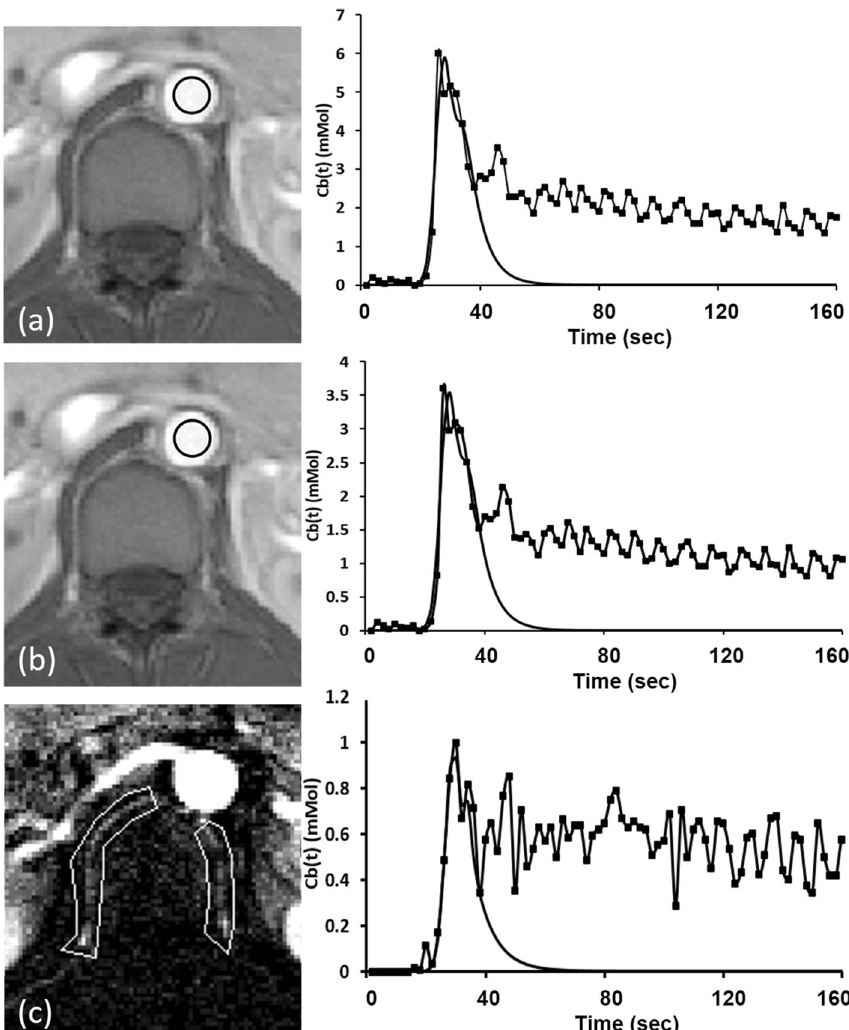
its mean concentration time curves (solid line; squares indicate data points) and arterial input functions (solid line alone), fitted using a mixture between a Gaussian function and an exponential function modulated by a sigmoid